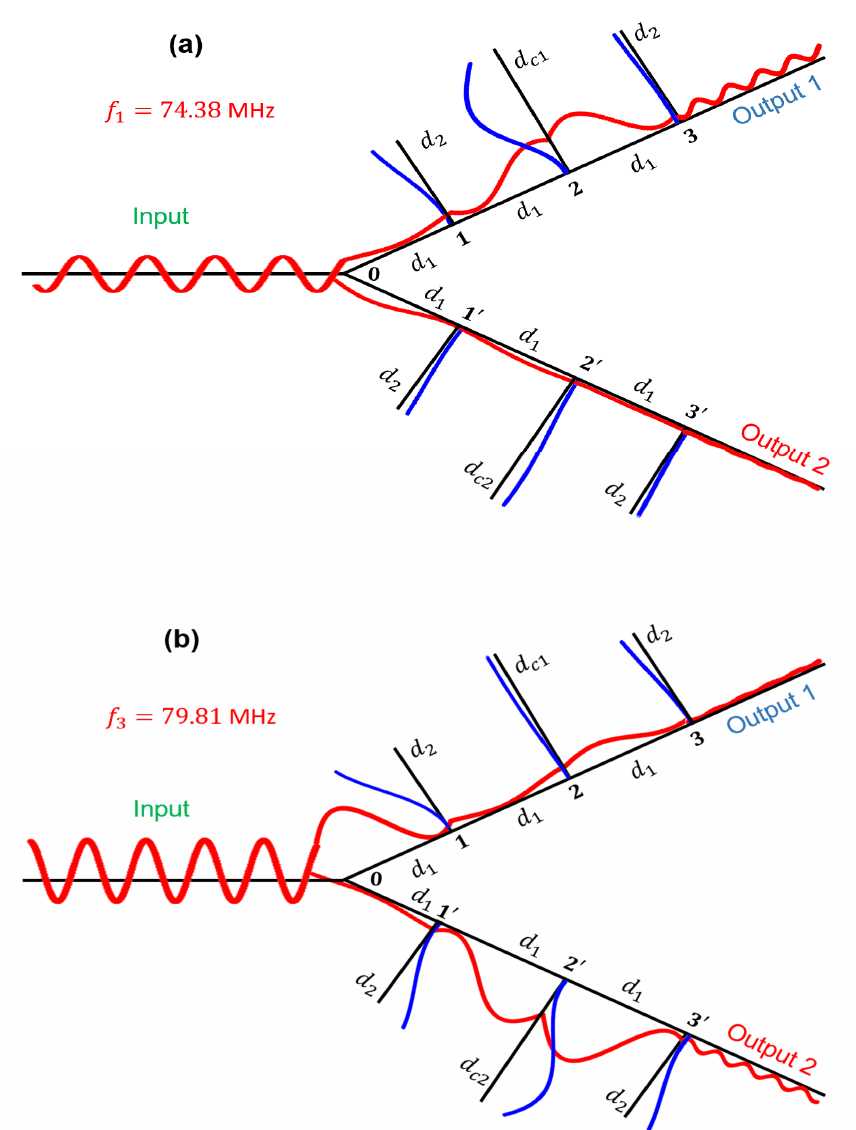
Figure 10. Square modulus of the displacement field | E | 2 (in arbitrary units) along the two outputs of the demultiplexer at ( a ) f 1 = 74.38 MHz for d c